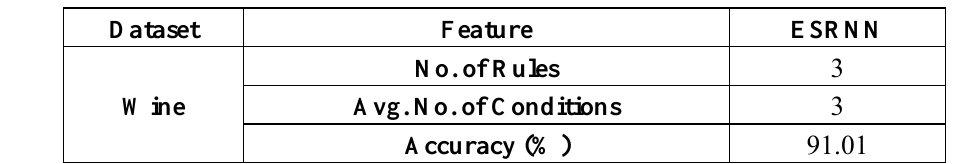
Table 12. Performance of the ESRNN algorithm for the wine data.